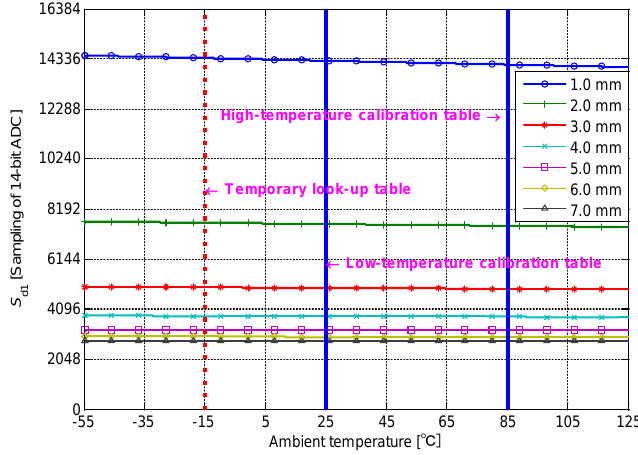
Figure 10. Process of calibration and calculation.